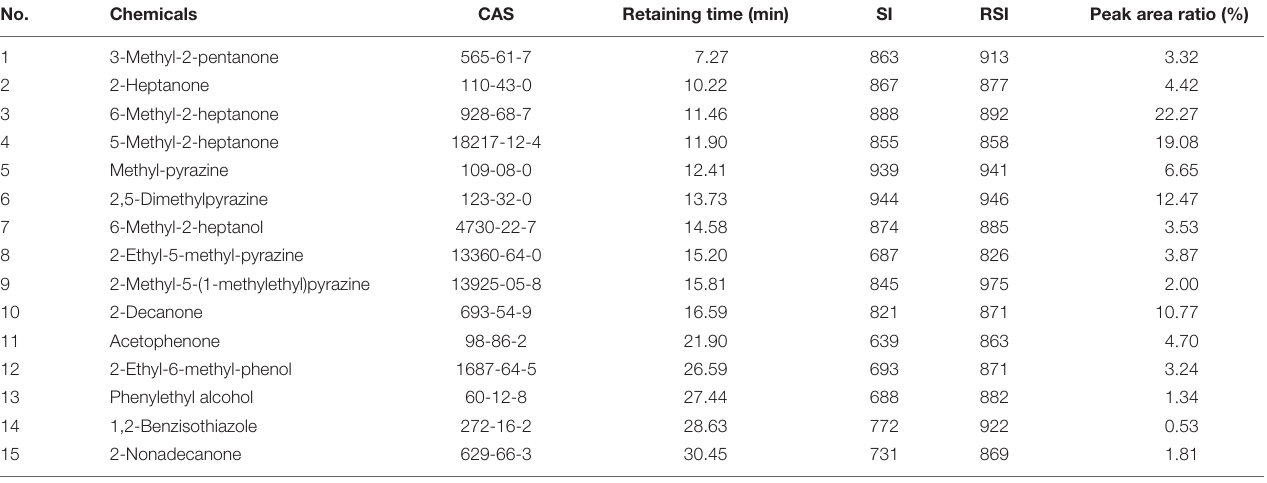
TABLE 1 | Volatile compounds produced by Bacillus subtilis ZD01 identified under optimal conditions using an free fatty acid phase (FFAP) chromatographic column. No.